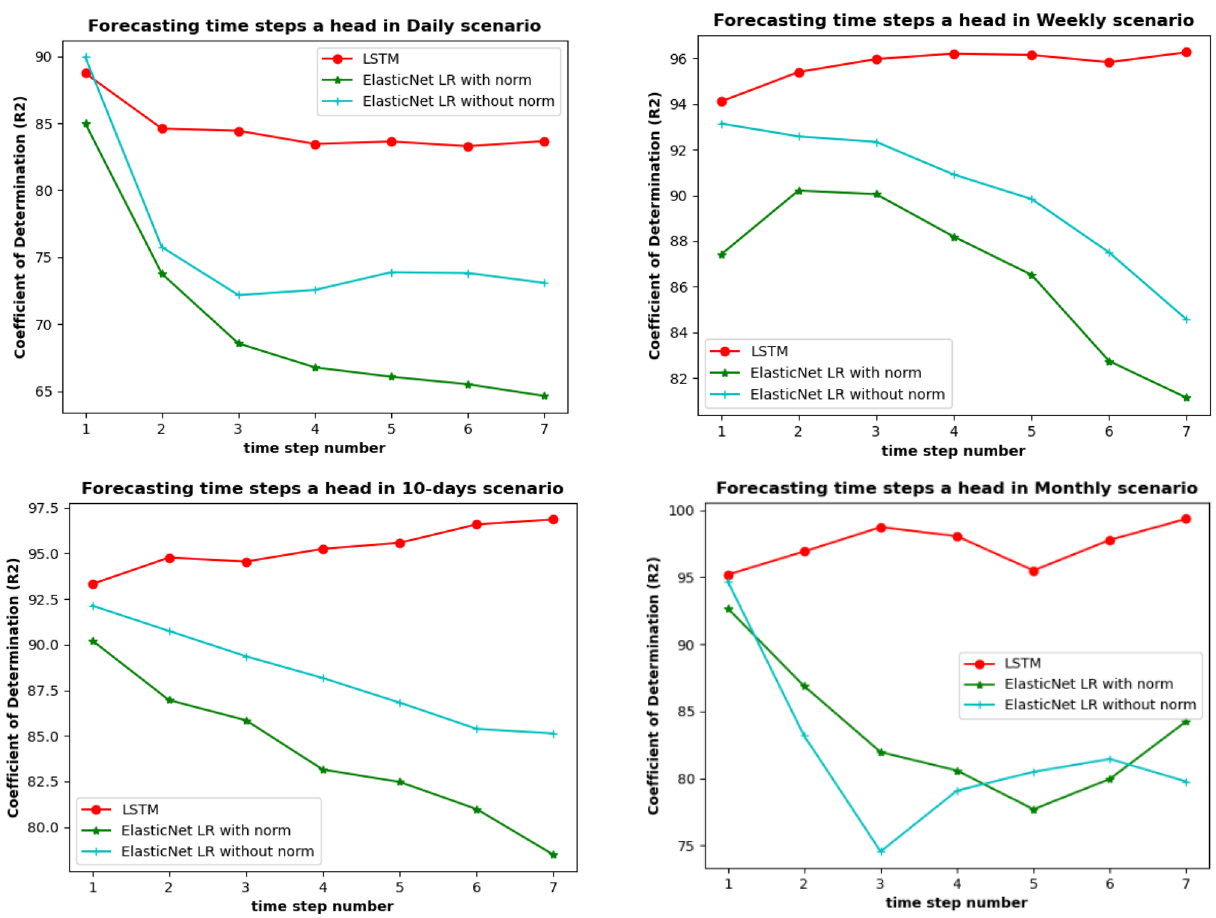
Figure 13. Coefficient of determination for the four scenarios four two models to predict from one to seven days